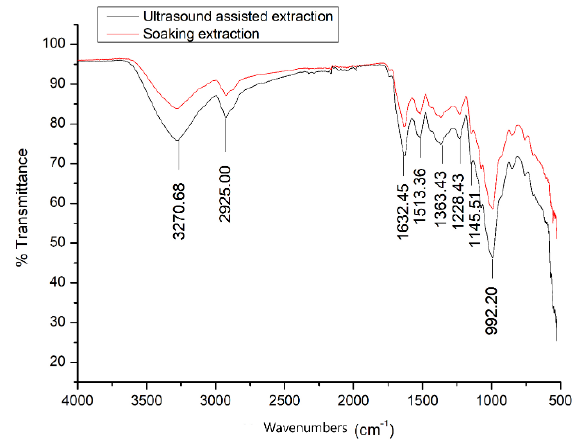
Figure 5. FT-IR spectra of the raw and treated common beans.